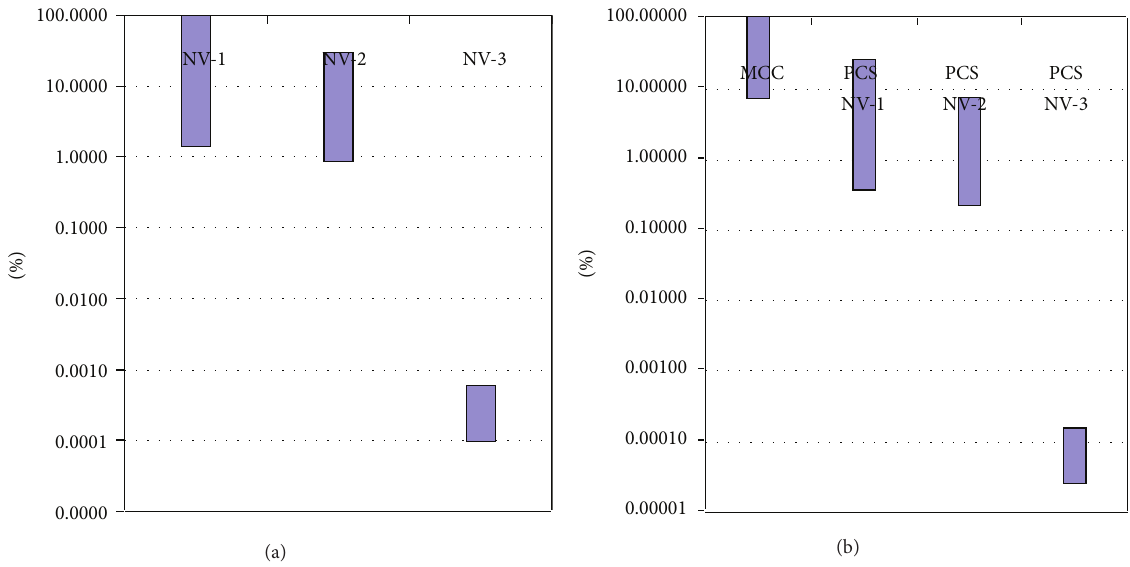
Figure 3: (a) Distribution of relative deposits activity of PCS subsystem components (PCS-i/PCS-6), (b) distribution of relative deposits activity on PCS subsystem components compared to the MCC main circulation pump activity (PCI-I/MCC